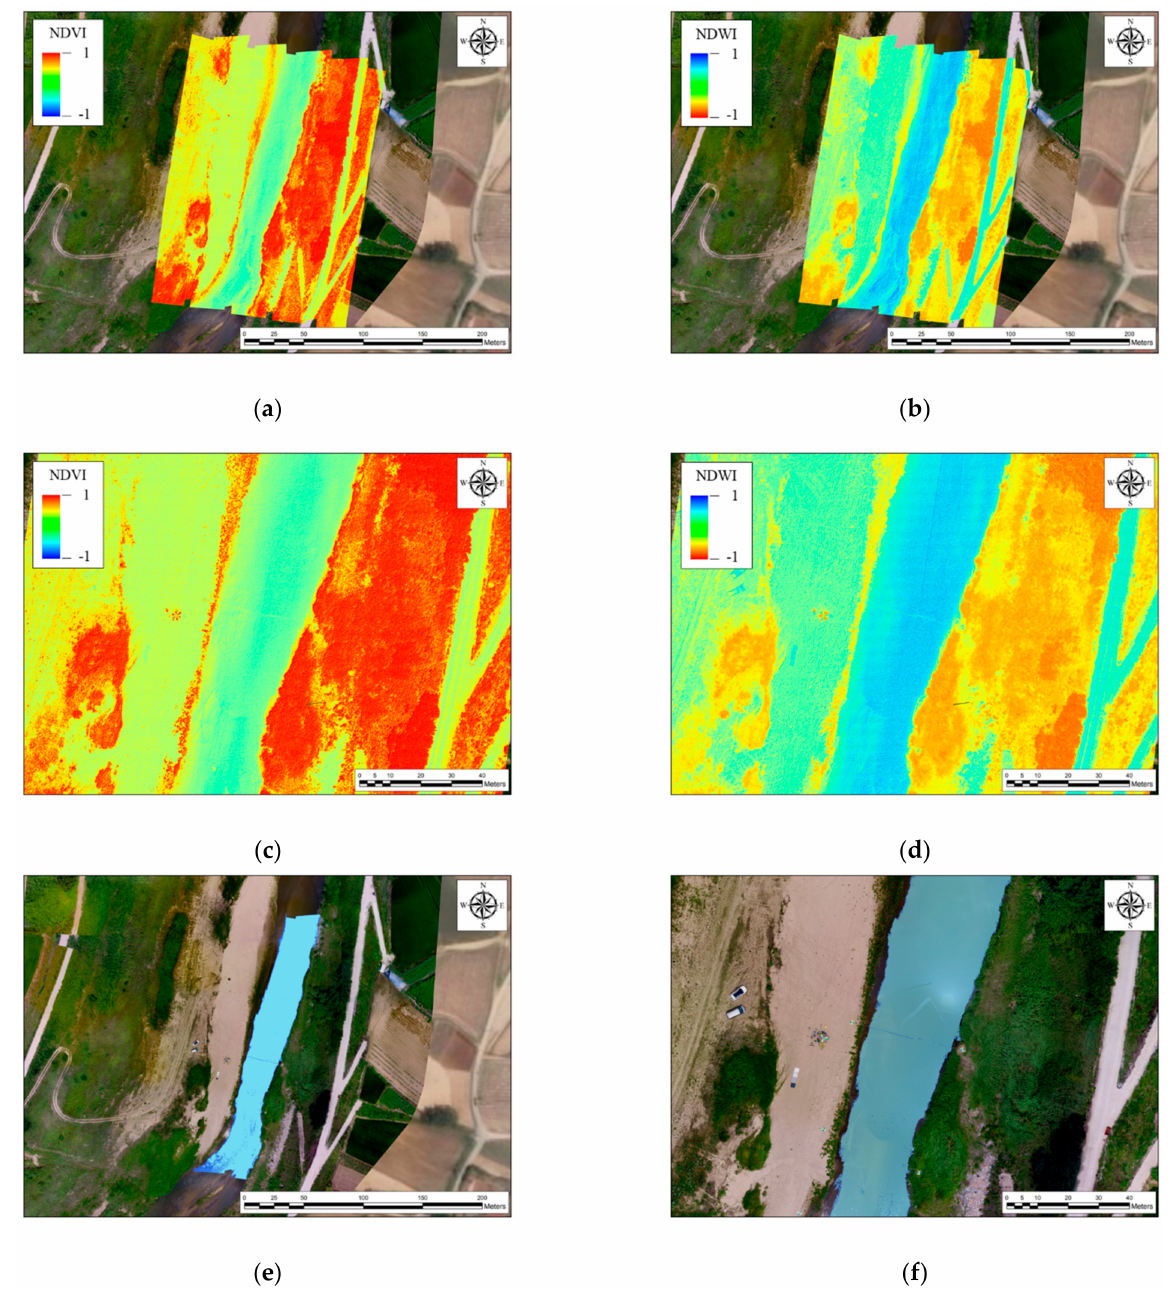
Figure 14. Hyperspectral imagery measured using the proposed technique: ( a , b ) spatial representations for results calculated for NDVI (Normalized Differential Vegetation Index) and NDWI (Normalized Differential Water Index), respectively; ( c , d ) respective enlargements; ( e ) area where the NDWI was higher than zero; ( f ) extracted river water body